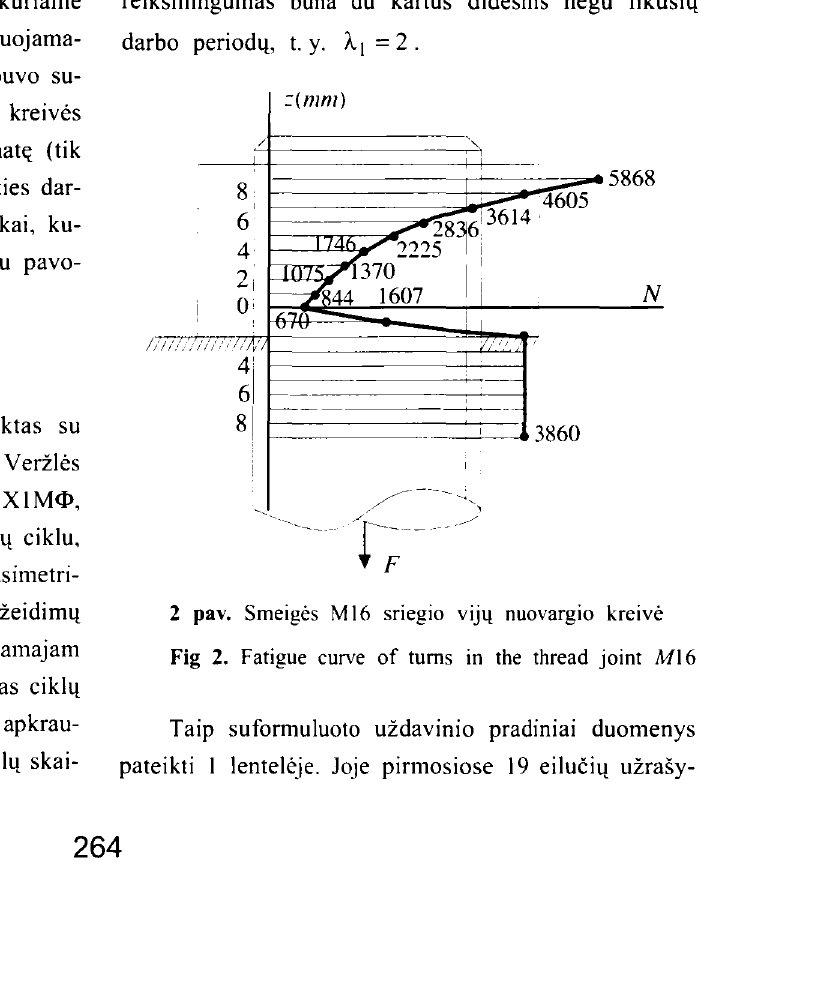
Fig 2. Fatigue curve of turns in the thread joint Ml6 Taip sufommluoto uzdavinio pradiniai duomenys